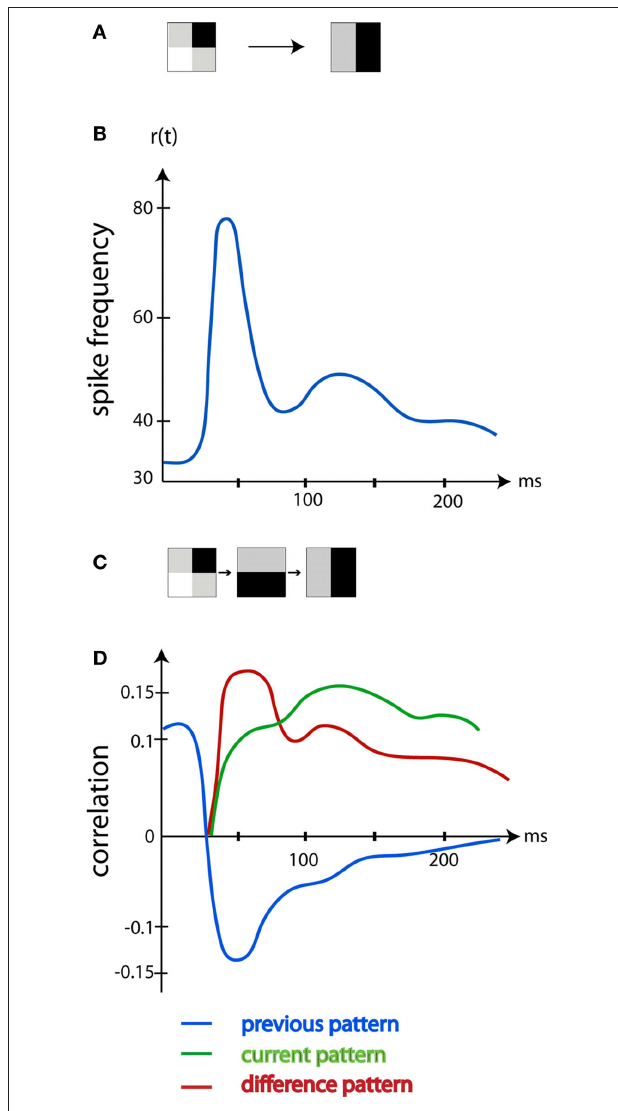
Figure 3 | The image decoded by the area 17 neurons changes over time. (A) The left pattern was shown. At time 0 ms the pattern shifted to the right pattern. (B) The mean r ( t ) in Hz of the area 17 neurons mapping the new pattern (average of five animals). (C) The old pattern (left), the difference between the old pattern and the new pattern (middle), the new pattern (right). (D) The average correlation between the old, the difference pattern and the new pattern and the r ( t ) of area 17 mapping neurons. Note that, corresponding to the ON response induced by the change to the new pattern, the neurons are mostly correlated with the difference between the old and the new pattern. After 90 ms the neurons code mostly for the current pattern. (Modified from Eriksson et al., 2010).